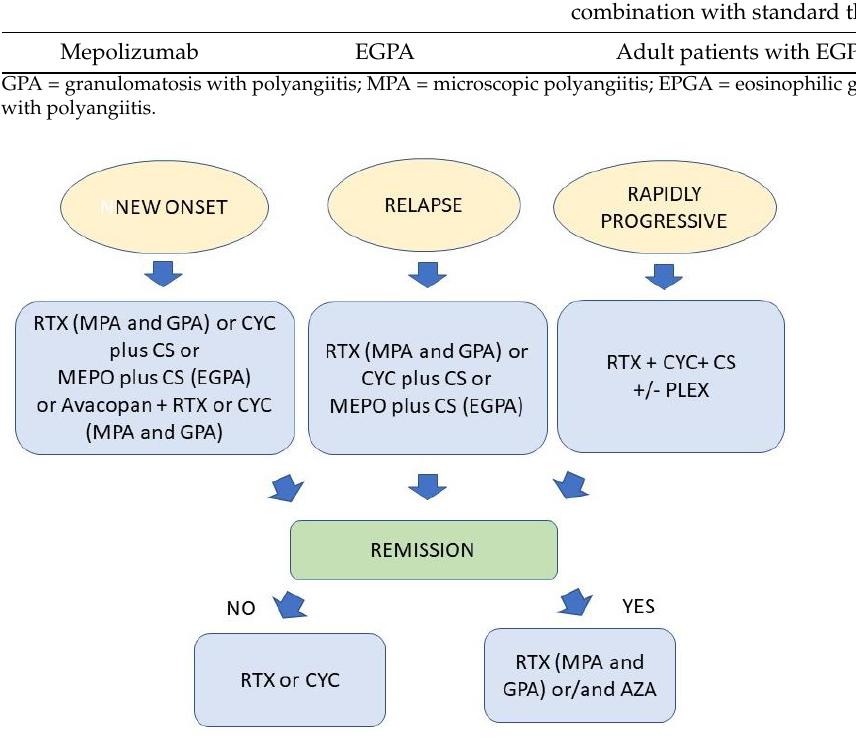
Figure 3. Algorithm for the treatment of AAV. Several strategies are used for induction of remission and maintenance of remission. In addition to conventional drugs such as cyclophosphamide (CYC) corticosteroids (CS) and azathioprine (AZA), new drugs that are able to selectively inhibit immuno- logic targets such as rituximab (RTX), avacopan, and mepolizumab (MEPO) have been approved by regulatory agencies. PLEX = plasmapheresis. Therapeutic strategies are periodically updated according to new knowledge by EULAR and